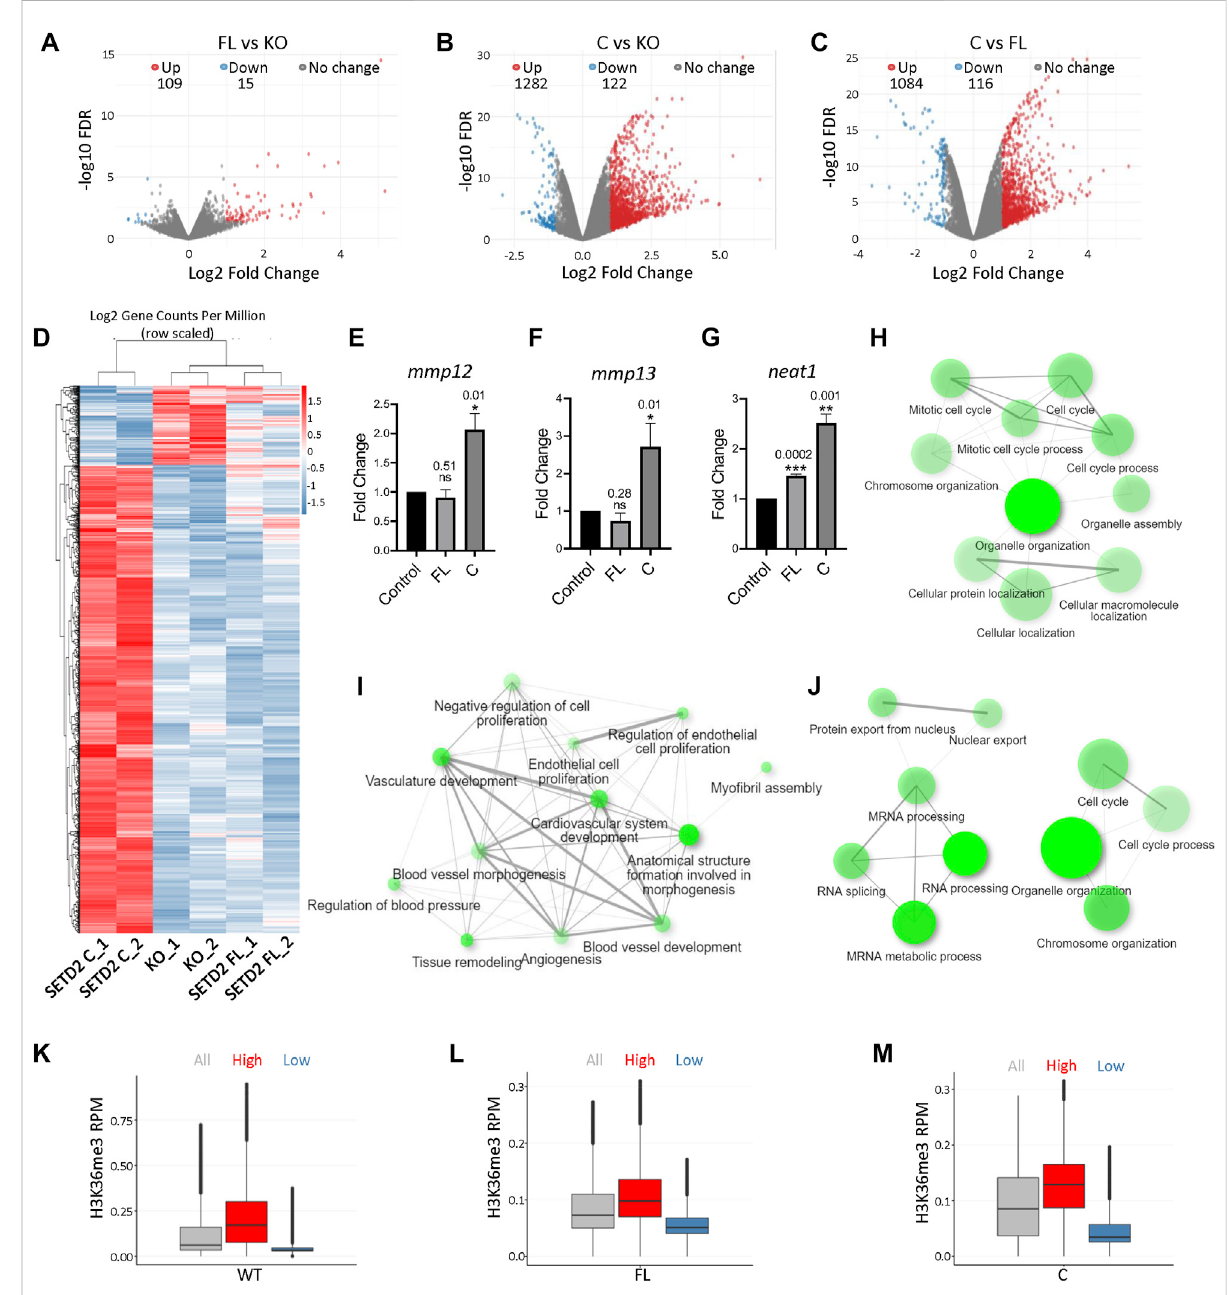
FIGURE 2 Removal of the SETD2 N-terminus leads to changes in gene expression. (A – C) Volcano plot showing the expression changes occurring upon expression of SETD2 FL and C in KO cells. Each dot represents a gene. RNA was isolated 72 h post-transfection. (D) Heat map showing differentially expressedgenesupontheexpressionofSETD2CandFLinKOcells. (E – G) RNAwasisolatedfromKOcells72 hpost-transfectionwithGFP-control, SETD2 full-length (FL), or SETD2 C (C). Speci fi c primers were designed to detect the indicated genes and quantitative PCR was performed. For each sample n = 3 independent biological samples were examined in the same sequencing run. Data are presented as mean values with a Standard Error of Mean. An unpaired t -test (two-tailed) was performed. p -value < 0.05 was considered signi fi cant. p -values are depicted on the top of the respective graphs. GAPDH was used for normalization. (H – J) GO-term analysis of genes upregulated upon expression of SETD2 FL and SETD2 C in KO cells using ShinyGO (http://bioinformatics.sdstate.edu/go/). (K – M) Box plot showing the H3K36me3 and expression level of genes. The expression cutoffs are 0 < TPM ≤ 2 and TPM ≥ 4 to de fi ne low- and high-expressed protein-coding genes, respectively, in FL and C samples; and 0 < TPM ≤ 0.1 and TPM ≥ 0.5 to de fi ne low- and high-expressed lncRNA genes, respectively, in FL and C samples. In the boxplots, the black line inside the box shows the median. The box bottom and top border correspond to 25th and 75th percentiles (Q1 and Q3 respectively). The whiskers represent rangesfromQ1 — 1.5*IQRtoQ3+1.5*IQRwhereIQRstandsforinterquartilerange(Q3 — Q1).Datapointsoutsidethewhiskerscouldbeoutliersand are marked as black